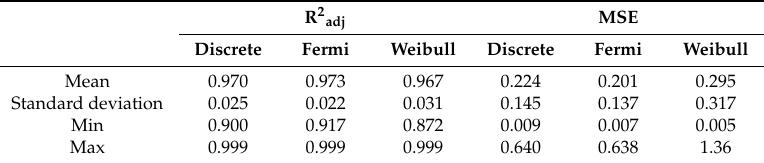
Table 1. Adjusted coefficient determination (R 2 adj ) and mean square error (MSE) values for the Discrete, Fermi, and Weibull models applied to 49 dose-response curves obtained from the literature. R 2 adj MSE Discrete Fermi Weibull Discrete Fermi Weibull Mean 0.970 0.973 0.967 0.224 0.201 0.295 Standard